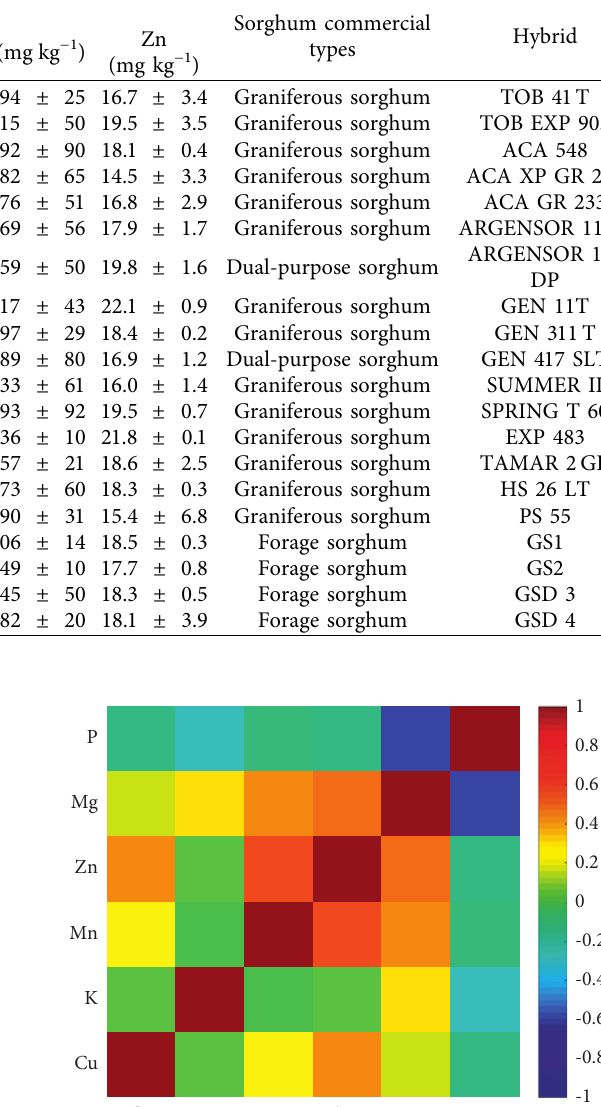
Table 4: Mean analyte concentrations ( n � 3) and standard deviations found in sorghum flours. Sample